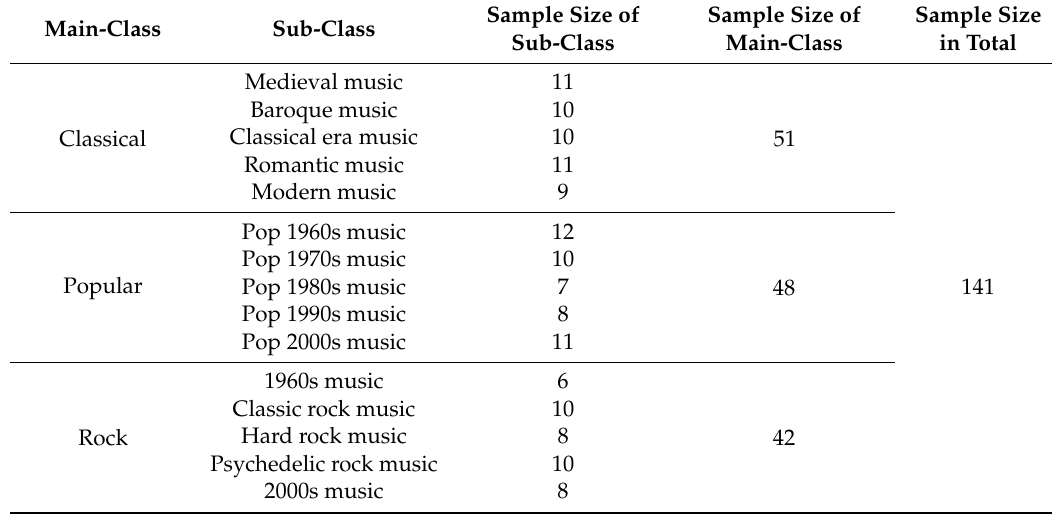
Table 3. The samples.